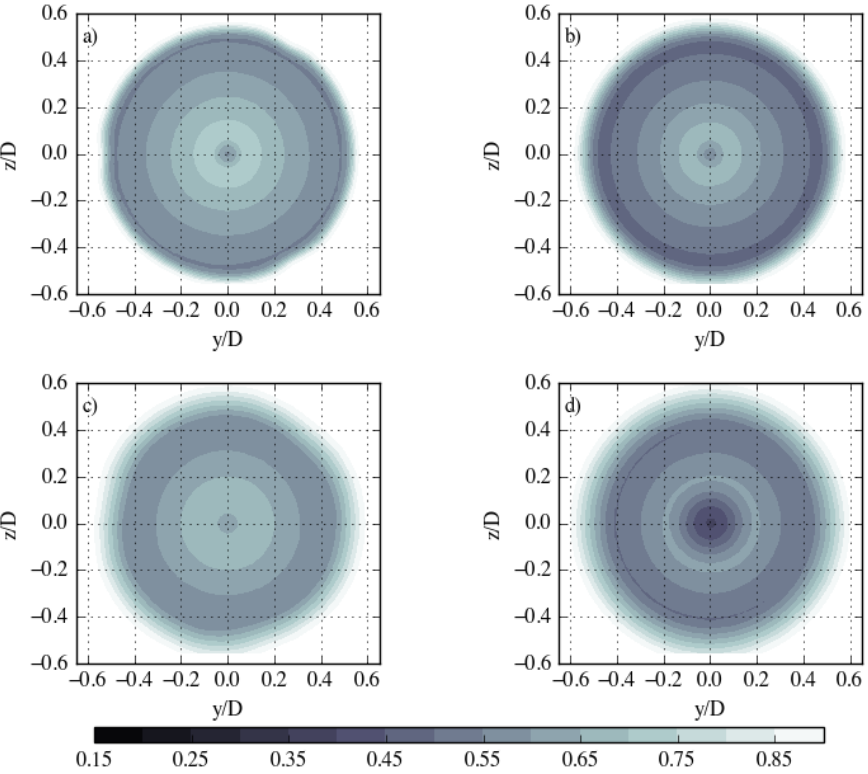
Figure 10. Numerical mean axial velocity at x / D = 1 ( a , b ) and x / D = 3 ( c , d ) for the balanced rotor ( left column ) and + 5 ◦ unbalanced rotor ( right column